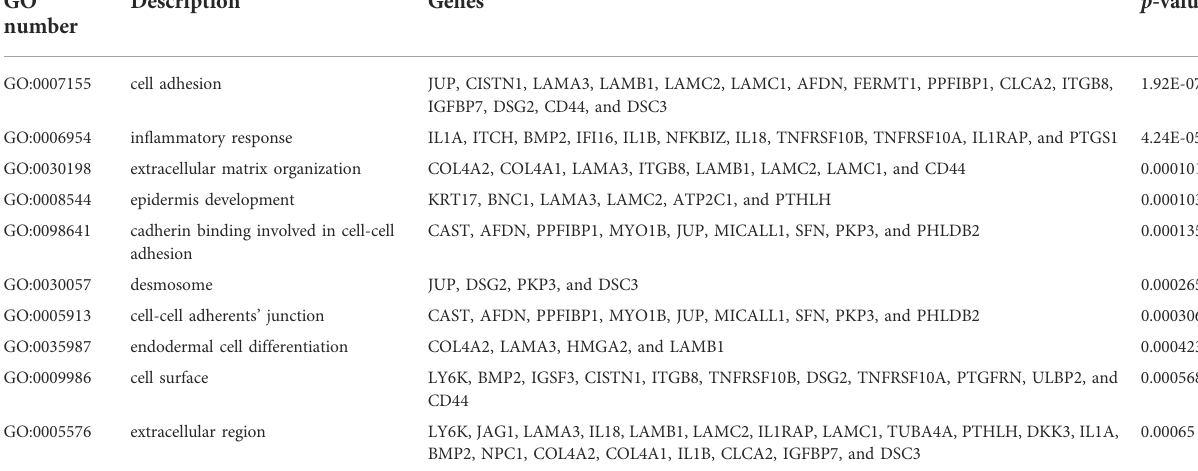
TABLE 4 Gene ontology analysis of LINC00958-related